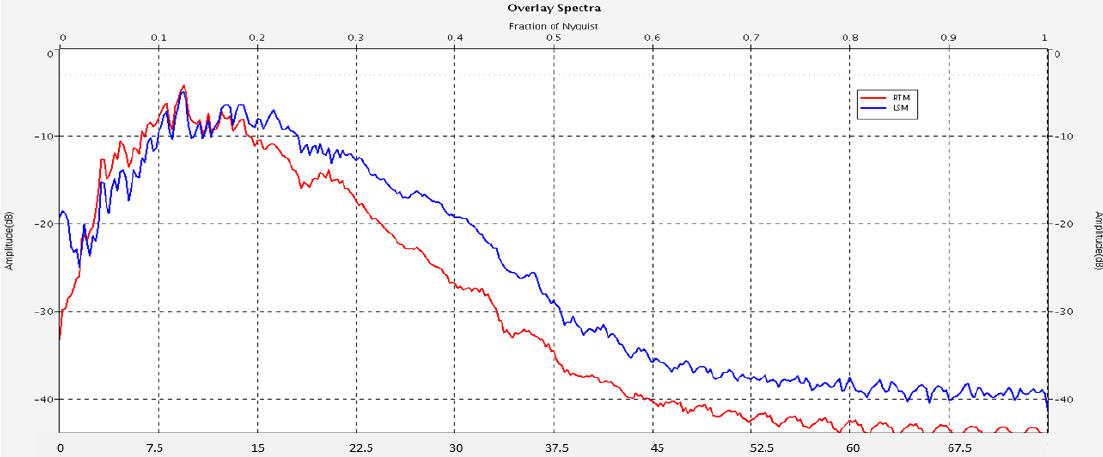
Figure 11. Comparison in vertical-wave-number spectrum (RTM: red line; LSM: blue line). The unit of y-axis is decibel, and x-axis indicates the wavenumber component.